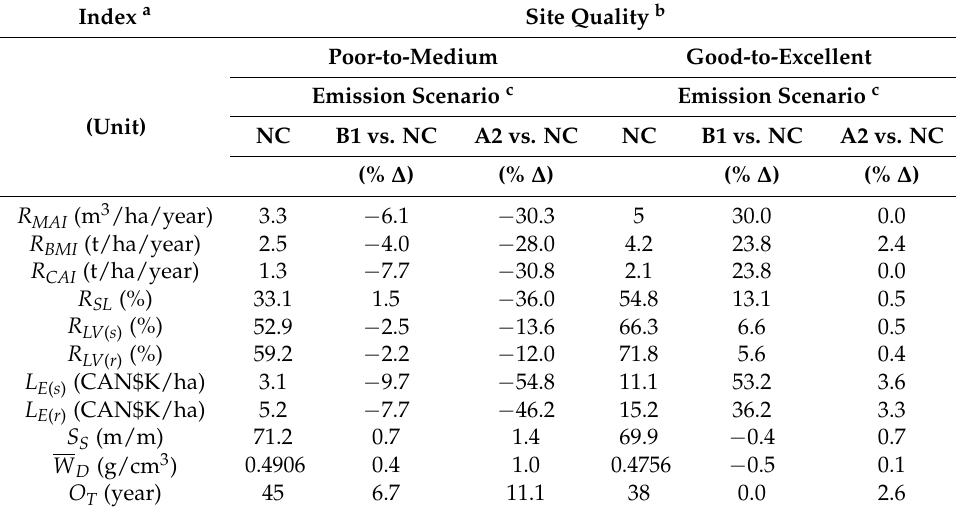
Table 3a. Stand-level performance indices for black spruce plantations managed under a basic silvicultural intensity in north-eastern Ontario by emission scenario and site quality.